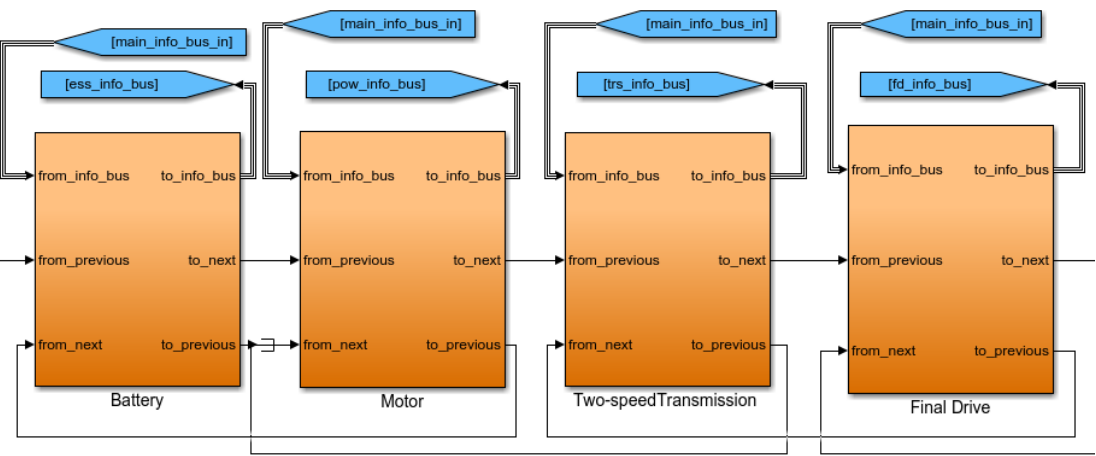
Figure 5. Block diagram of the powertrain.